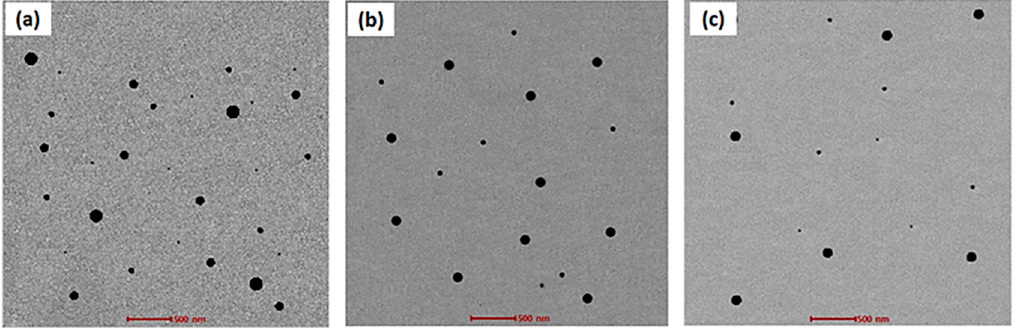
Figure 4. TEM images of the methotrexate-loaded nanoemulsion formulations: ( a ) FNE2, ( b ) FNE4, and ( c ) FNE6.